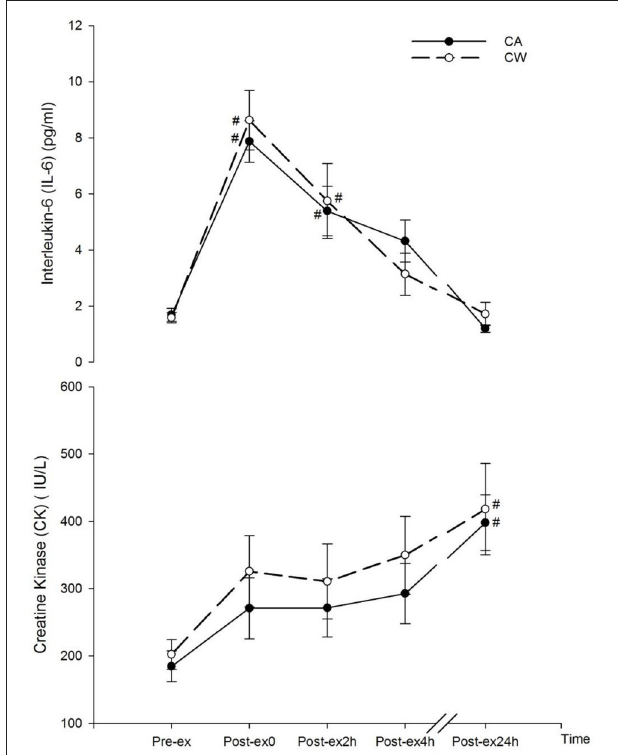
FIGURE 1 | Changes in CK and IL-6 following main trials ( # vs. Pre-ex0: P < 0.01). CA, CHO + Alpha-lactalbumin; CW, CHO + Whey PRO.